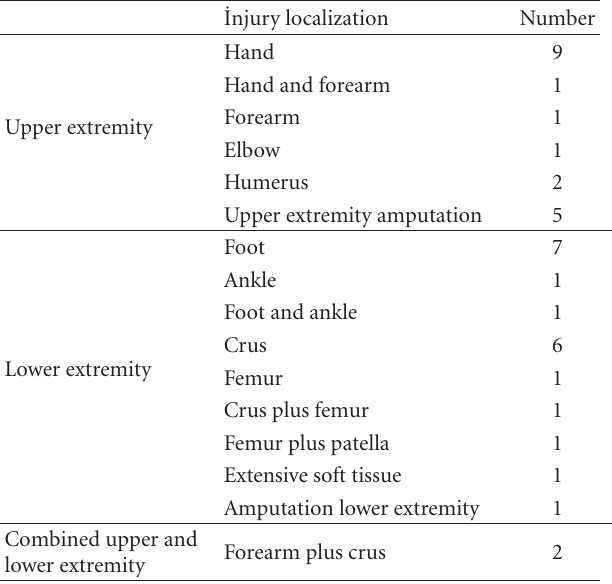
Figure 1: Foot crush injury in a farmyard accident. Wheat can be seen in the injured foot. Table 1: The anatomical localizations of the injured extremities involved on